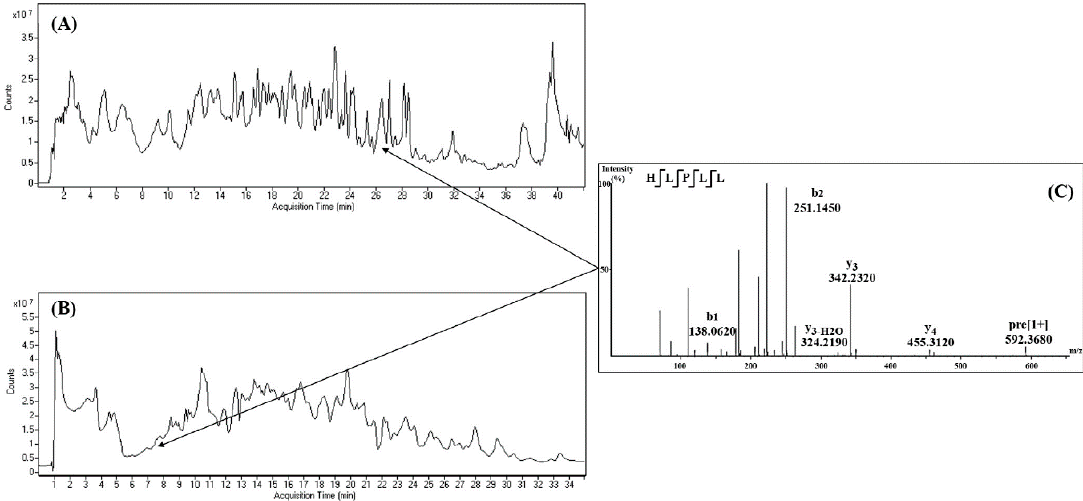
Figure 2. Total ion chromatograms corresponding to a hydrolysate obtained from plum seed proteins using Alcalase hydrolysate obtained by RP-HPLC ( A ), HILIC ( B ), and MS/MS spectrum of a peptide simultaneously observed in both chromatographic modes ( C ). With permission from [35].